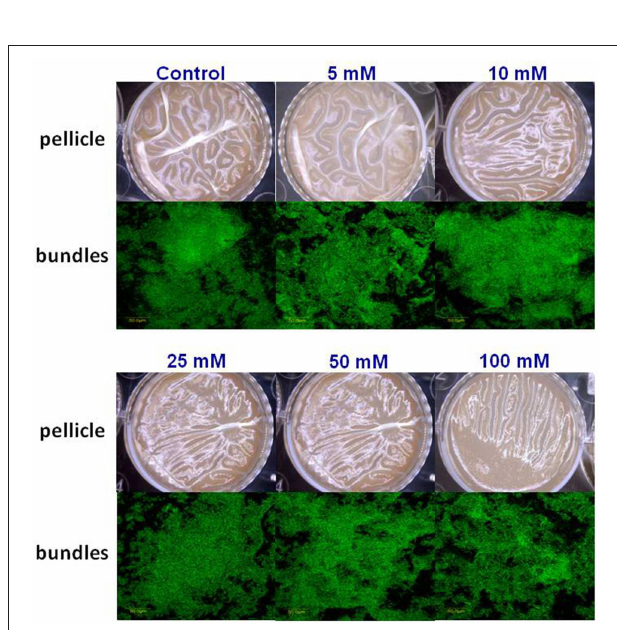
FIGURE 4 | The effect of Na + ions on biofilm formation by B. subtilis . The effect of addition of different concentrations of NaCl to LBGM medium on pellicle formation by B. subtilis NCIB3610.